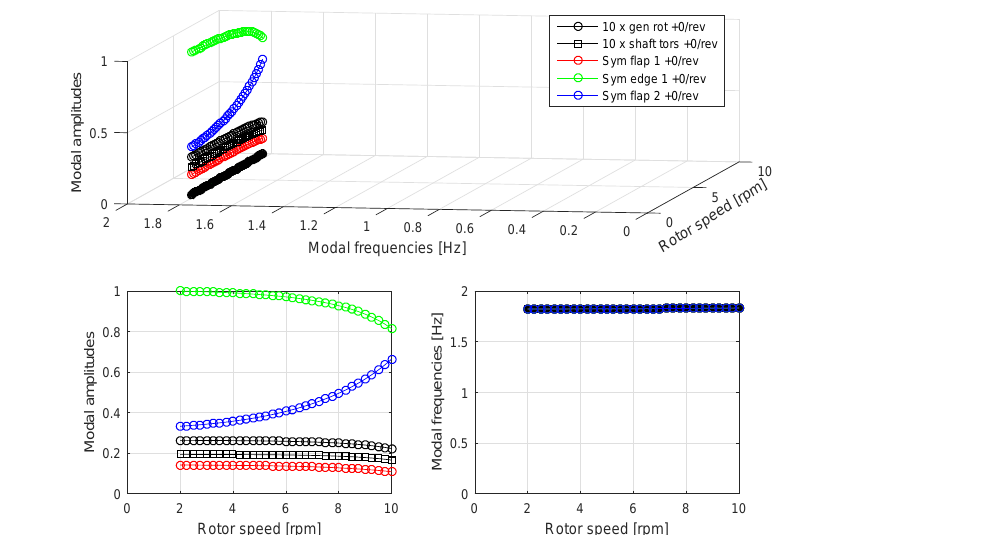
Figure 15. Harmonic modal components for the mode dominated by symmetric deflection of the rotor in the edgewise mode. Plot layout as in Fig.